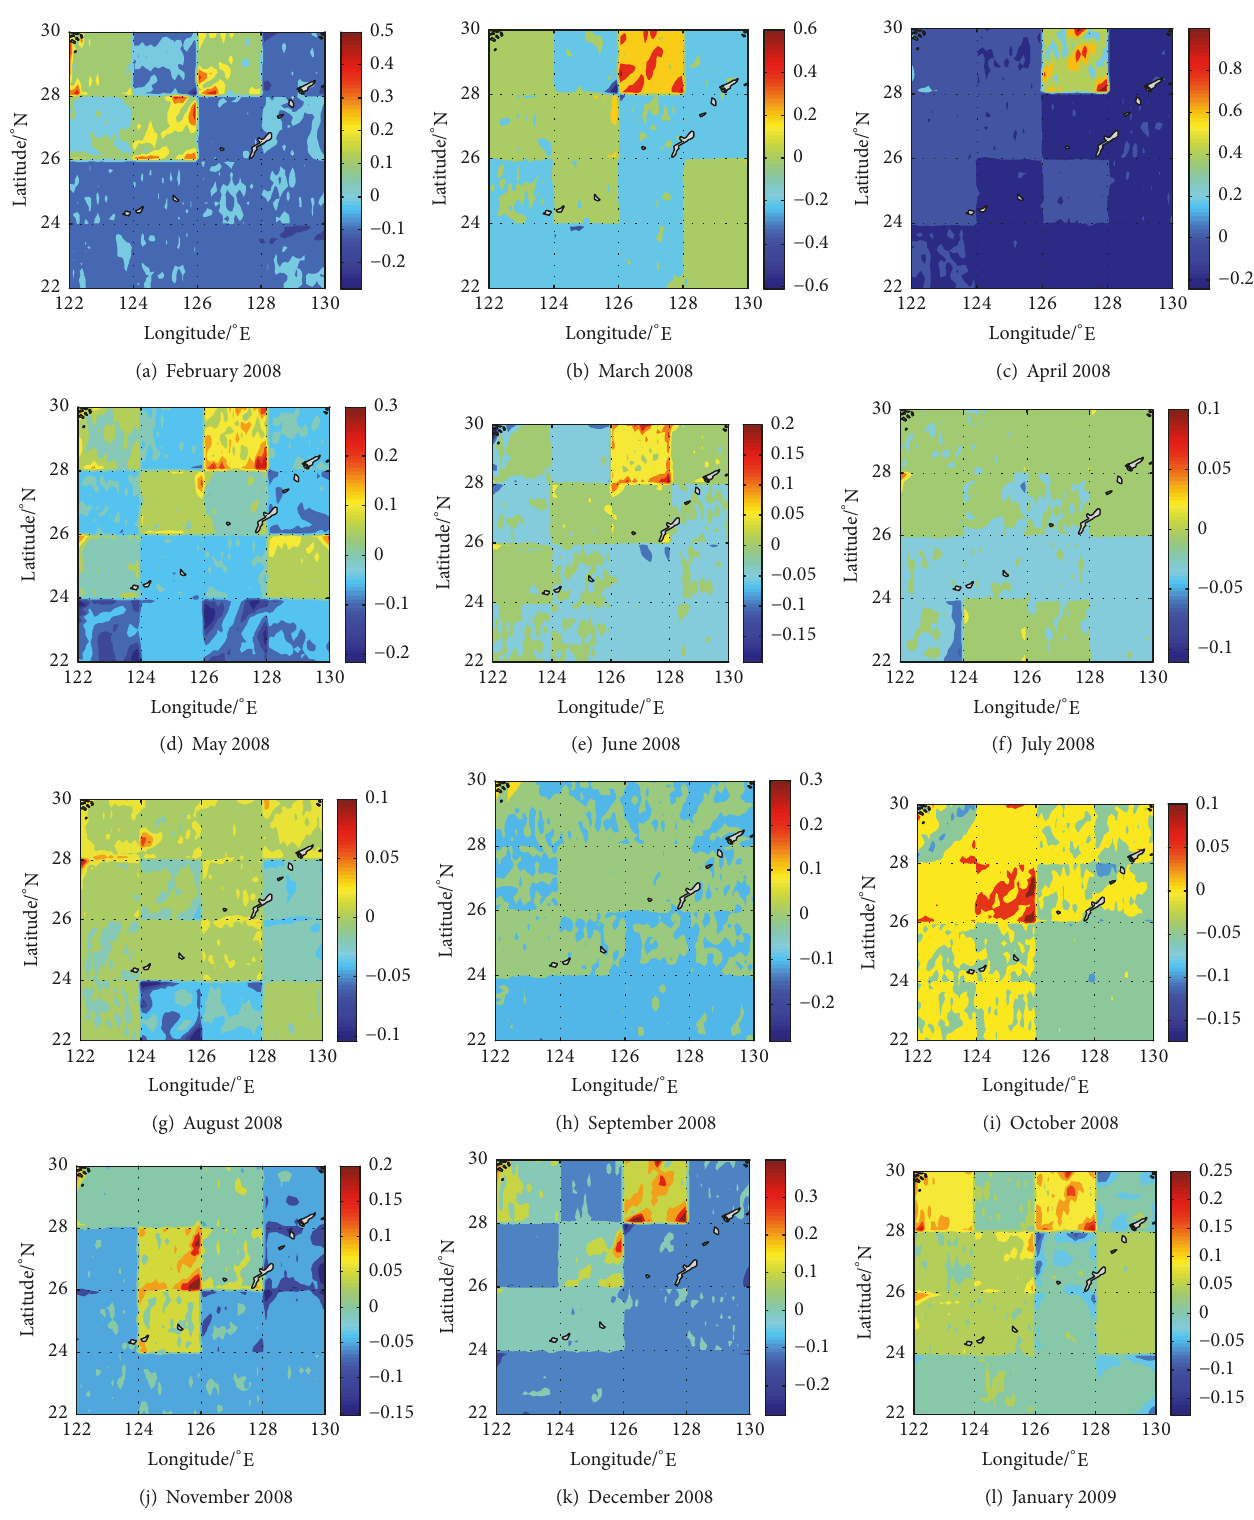
Figure 8: Difference of the reconstruction error in the sampled field from February 2008 to January